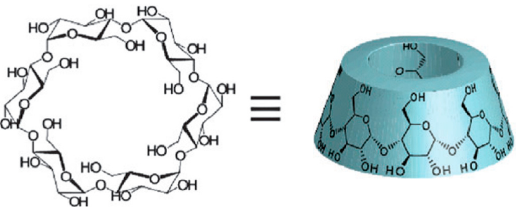
Figure 13. Structure of α -cyclodextrin (formed by six glucosidic units). The arrangement of the